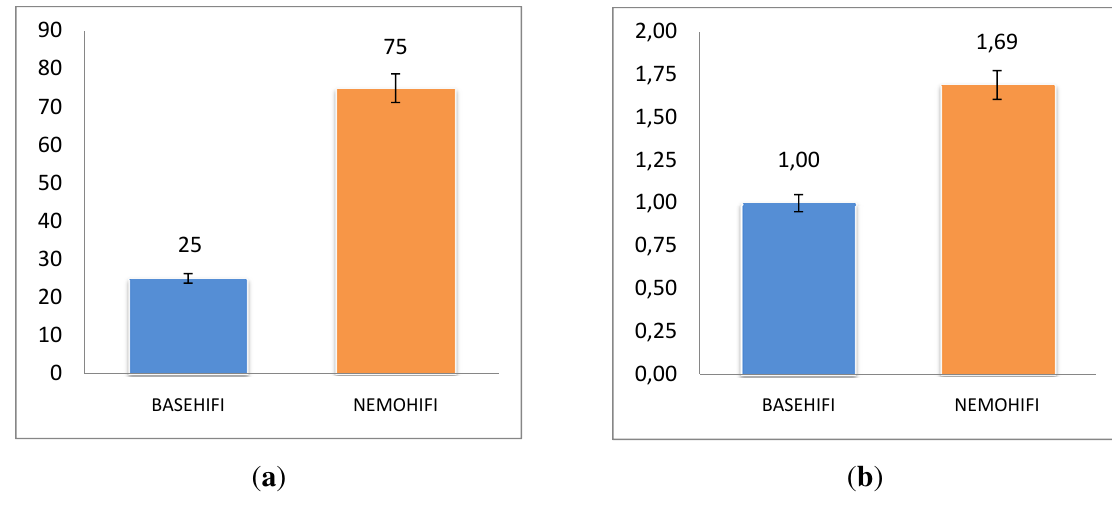
Comparisons of preference and satisfaction ratings between BASEHIFI and NEMOHIFI. ( a ) Preference percentage for both agents; ( b ) mean satisfaction ratings for both